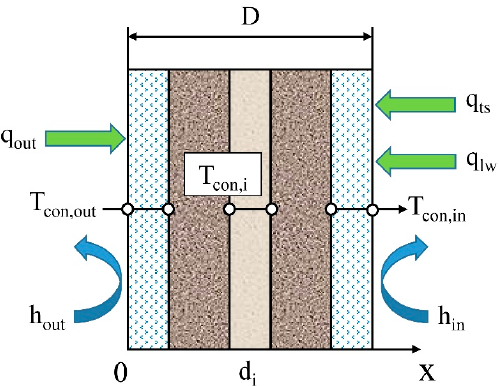
Figure 3. Heat transfer process of the building construction.